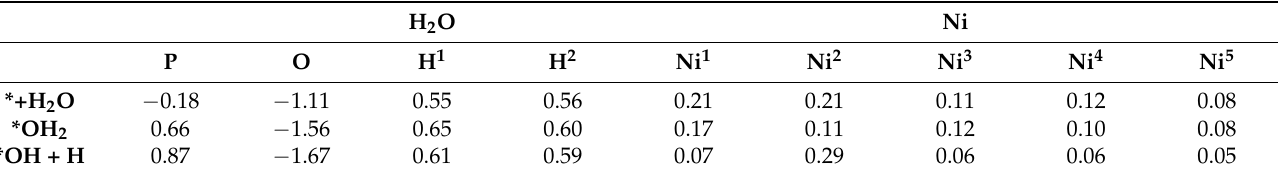
Table 3. Bader Charge Analysis of *+H 2 O, *OH 2 and *OH + H.